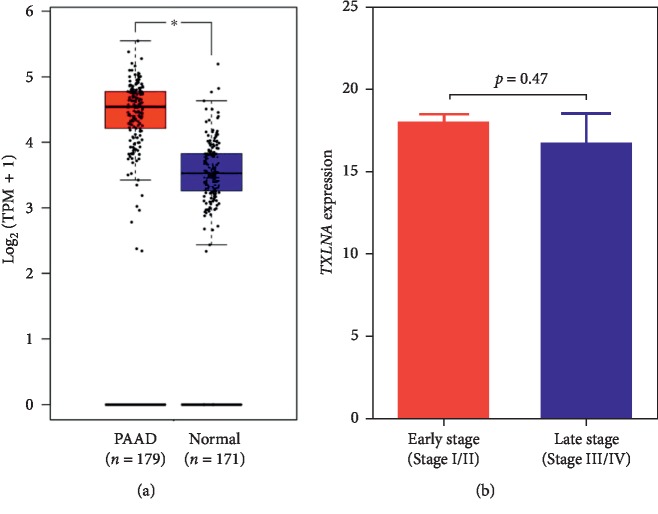
The TXLNA gene expression in pancreatic adenocarcinoma (PAAD) tissue and normal pancreas tissue. (a) The TXLNA expression in tumor tissue and normal tissue was analyzed using Gene Expression Profiling Interactive Analysis (GEPIA). (b) The TXLNA expression at early and late clinical stages of PAAD cases was analyzed based on the TCGA dataset. TPM, transcripts per million reads.